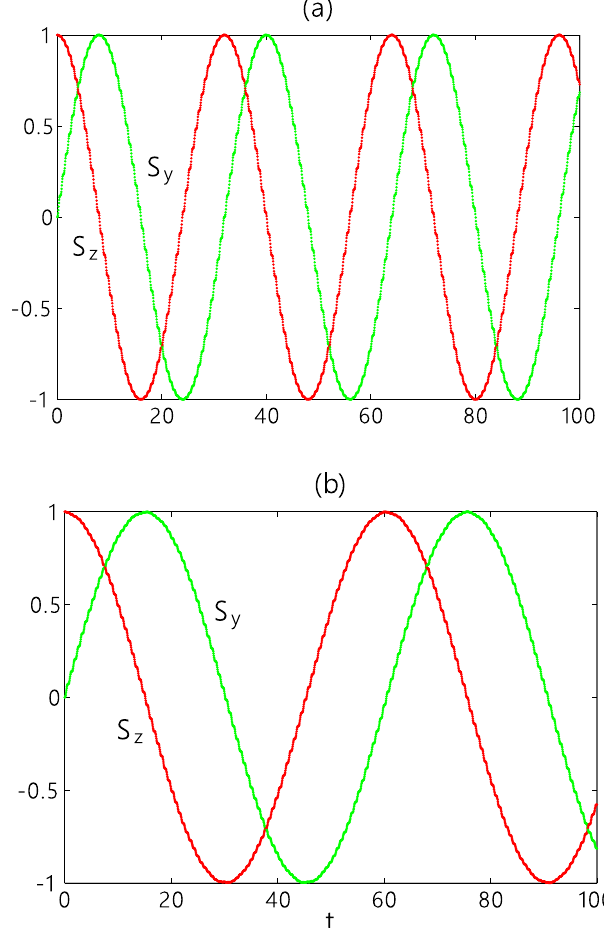
Figure 3. The time evolution of the y - and z -components of the pseudo-spin polarization vector for the graph of three sites ( a ) and that of five sites ( b ) with parameter choices J = 1 and 10  = . The initial states are |1, − 〉 in ( a ) and | −〉 + | −〉 ( 2, 1, )/ 2 in ( b